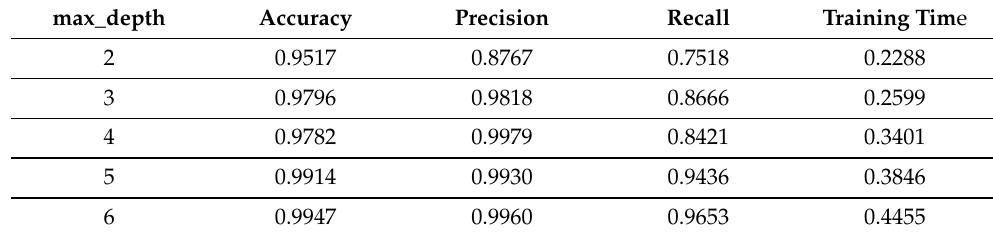
Table 4. Impact of max_depth on accuracy, precision and recall rates for the random forest classifier.